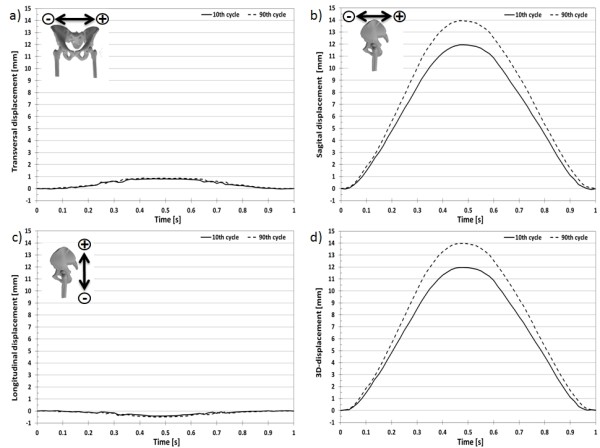
3D-displacement of the front pelvis marker at the iliac crest. 3D-displacement of the front pelvis marker at the iliac crest at the 10th and 90th loading cycle with a sinusoidal load between 100N and 900N.